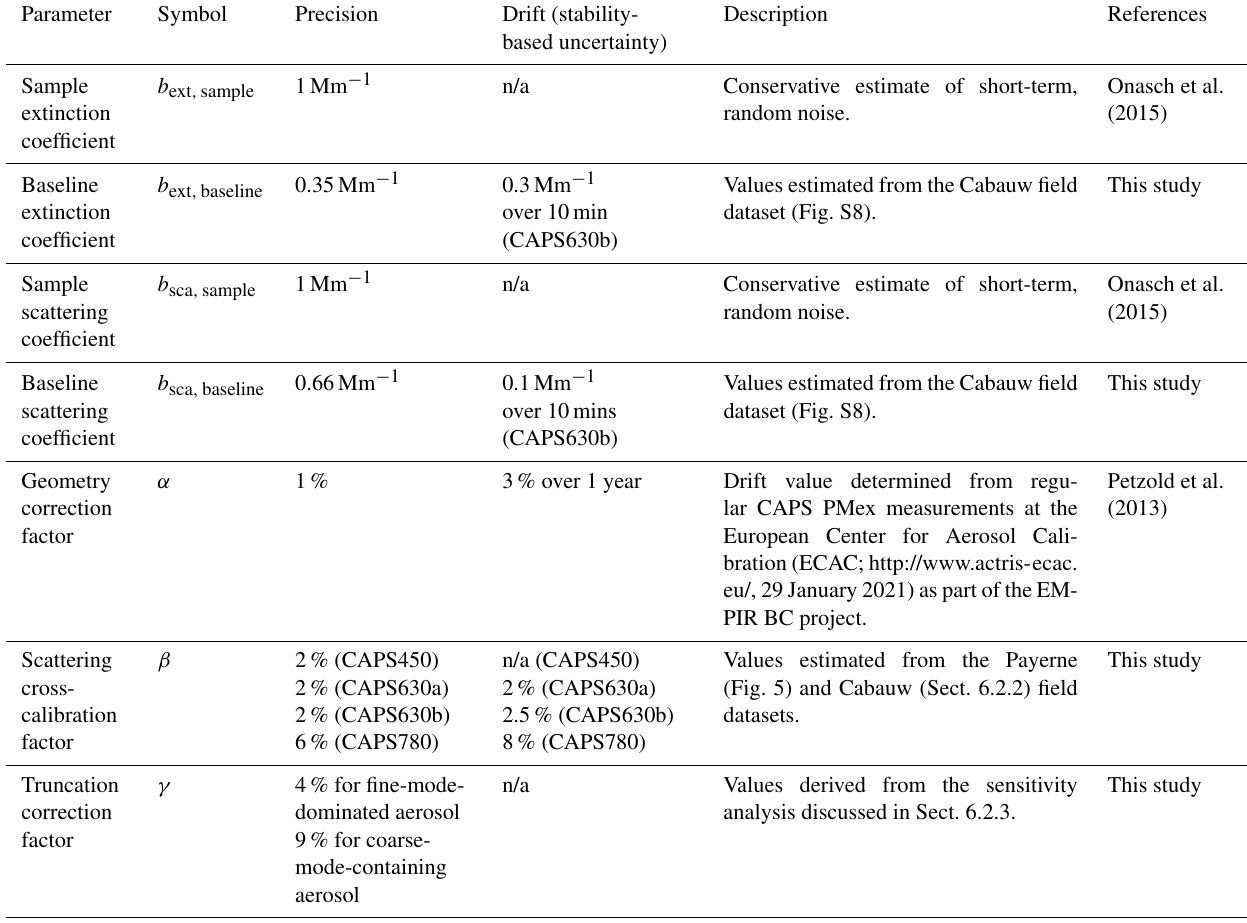
Table 1. Summary and description of uncertainties in the individual parameters comprising the error model described in Sect. 2.3. The precision column represents uncertainty due to the limited precision with which a particular parameter can be determined during calibration or measurement, and the drift column represents uncertainty due to possible drift of a parameter between available measurements. Estimated values are taken from previous studies or this study as indicated. The estimated values with units of Mm − 1 correspond to absolute errors, and those with percentages relative errors.